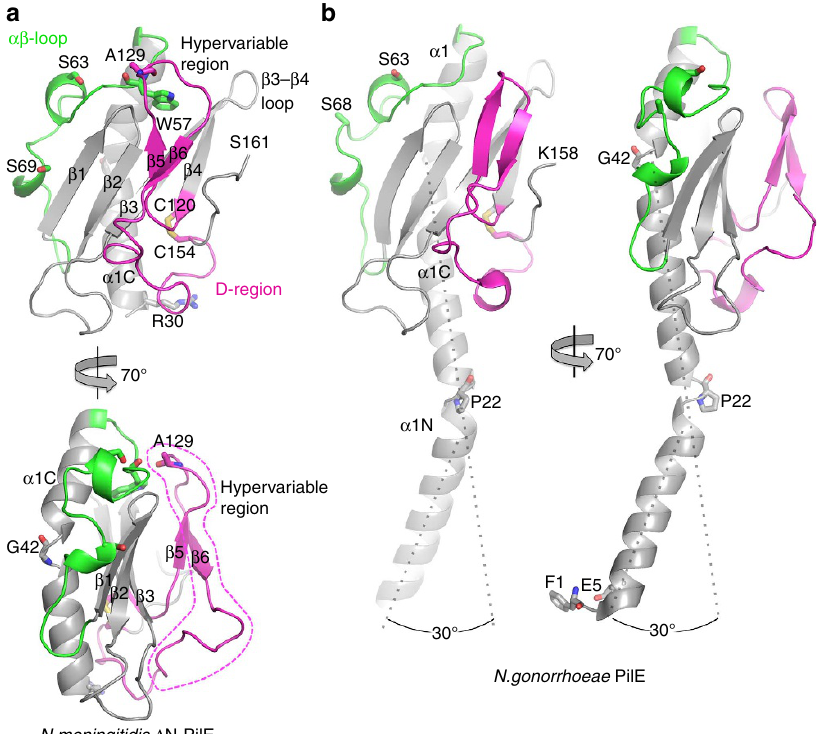
Figure 2 | X-ray crystal structure of N. meningitidis D N-PilE and comparison with the full-length structure of Ng PilE. Two views of ( a ) Nm D N-PilE and ( b ) Ng PilE pilins are shown: a ‘surface view’ predicted to form the outer face of the T4P filament, and a 70 (cid:2) rotation. The ab loop is shown in green and the D-region is shown in magenta, with the hypervariable region within the D-region outlined in the lower panel. Secondary structures are indicated. Nm D N-PilE residues Ser63 and Ser69 are post-translationally modified in the native pilin, as are the corresponding Ser63 and Ser68 shown in the full-length Ng PilE structure. The Ng PilE N-terminal a -helix, a 1, is kinked at Pro22 and Gly42. The N-terminal half of a 1, a 1N, is absent in the Nm D N-PilE structure, but is identical in sequence and thus expected to share the same conformation as in Ng